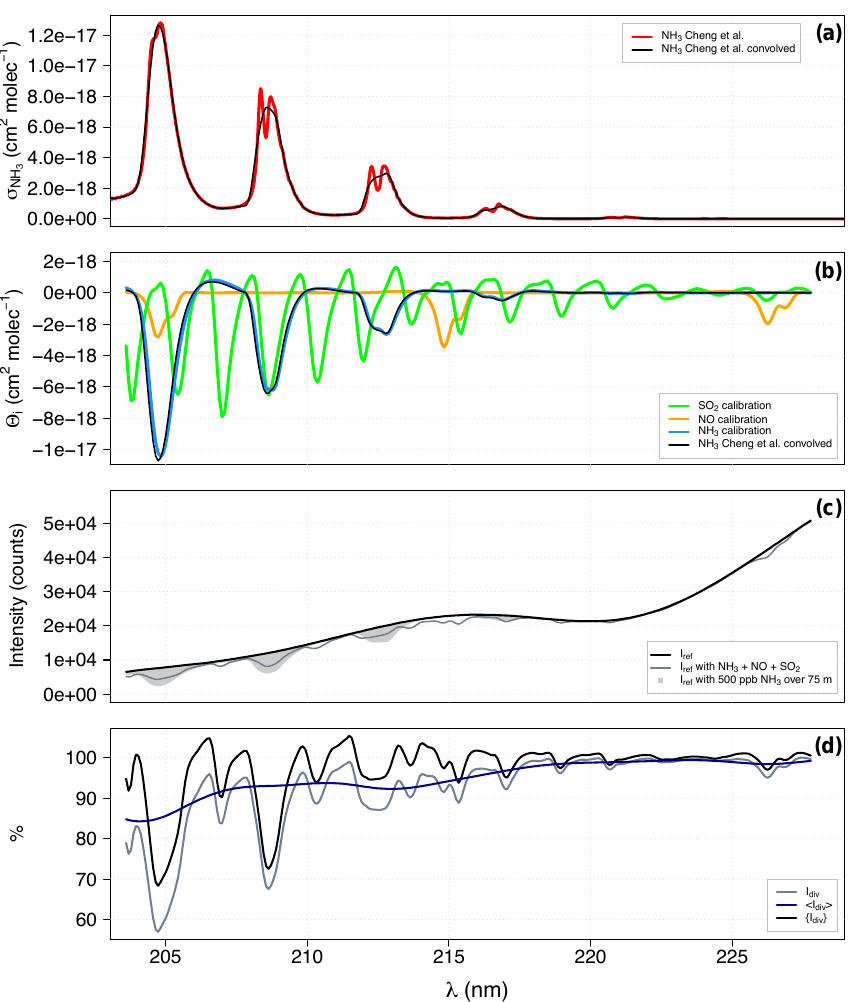
Figure 2. miniDOAS calibration-derived differential absorption cross sections (cid:50) i and literature-derived absorption cross section σ NH including example data evaluation steps; (a) σ NH by Cheng et al. (2006) including convolution to the CCD pixel resolution, (b) (cid:50) i (ob- 3 tained from { I div } by instrument N2 calibration, performed with cuvette concentrations of 191.9mg NH 3 m − 3 , 76.3mg SO 2 m − 3 , 594.0mg NOm − 3 ) and compared to the literature values for NH 3 as shown in (a) , (c) spectrum I ref and I adj including simulated absorption by NH 3 alone and all three gas species combined and (d) different evaluation steps for I div using the combined spectrum from (c)